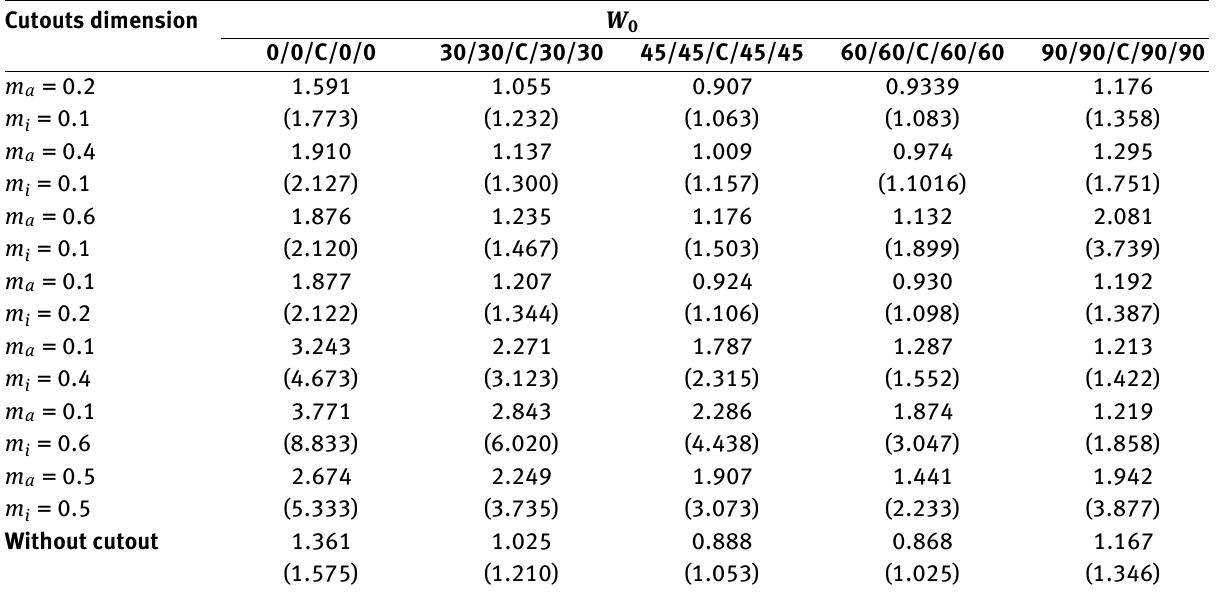
Table 5: Effect of stacking sequence with cutout dimensions on simply supported (S2) laminated sandwich square plate Cutouts dimension